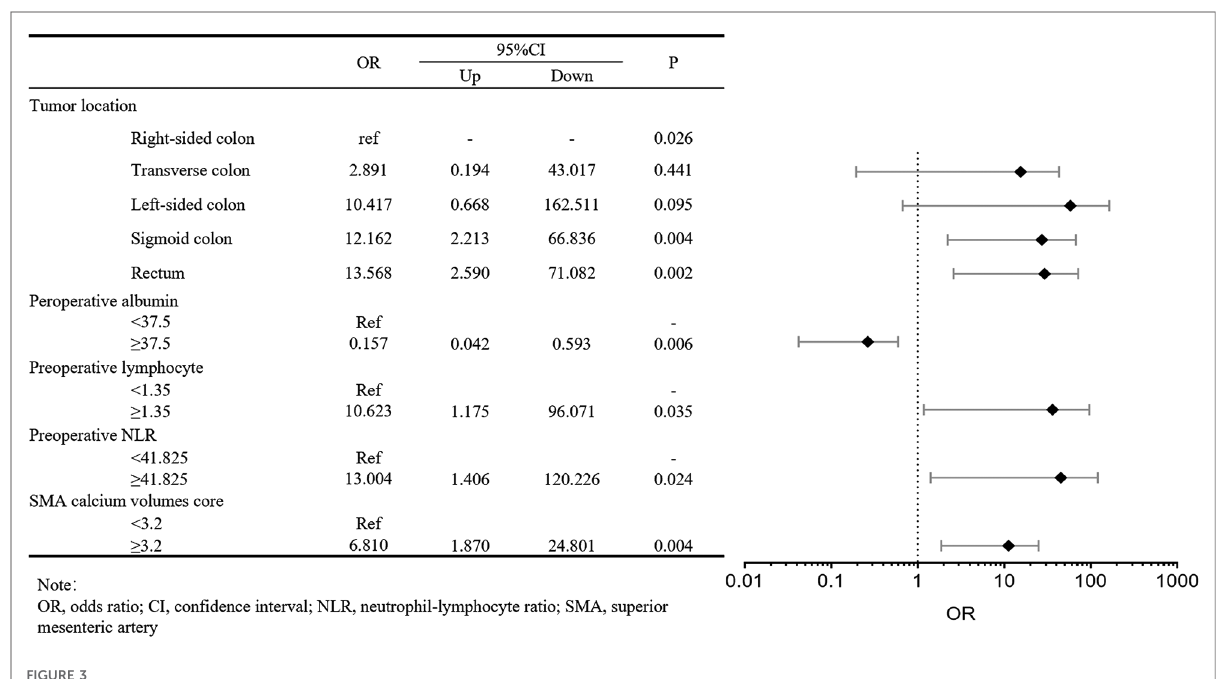
FIGURE 3 Forest plot about multivariate logistic regression analysis of clinicopathologic characteristics in the training cohort for anastomotic leakage.